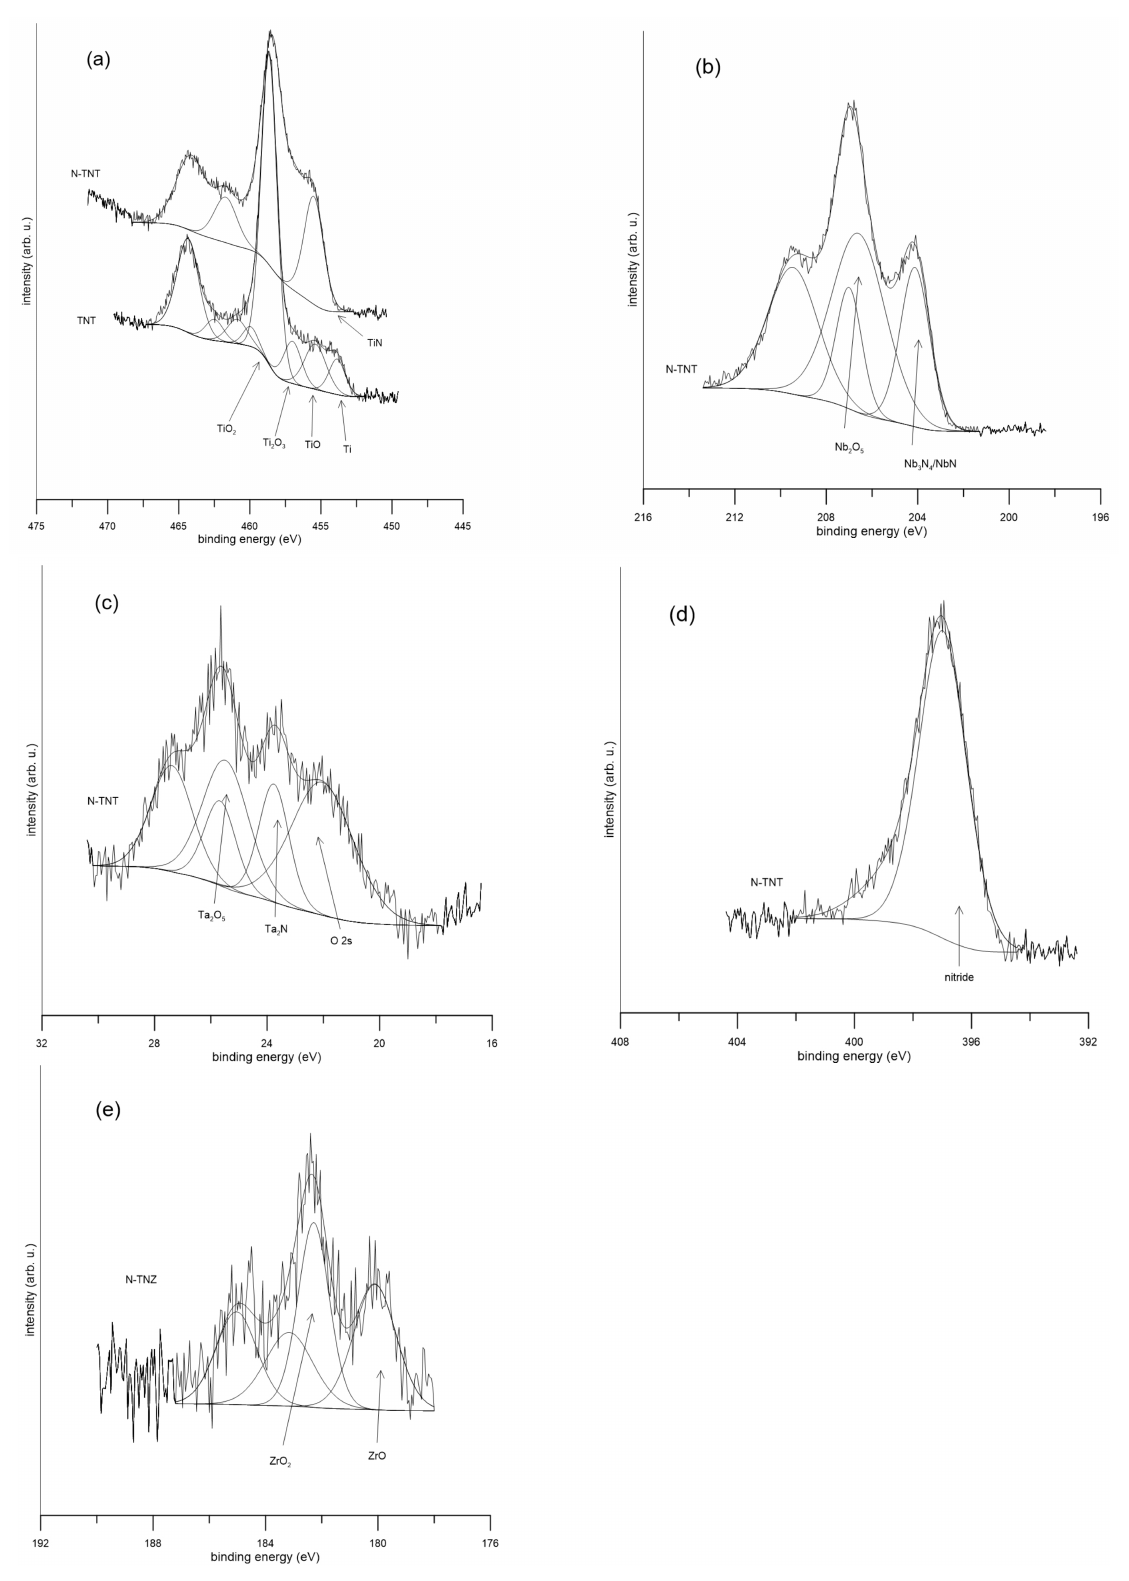
Figure 1. Detailed XPS spectra of selected elements: ( a ) Ti 2p, ( b ) Nb 3d, ( c ) Ta 4f, ( d ) N 1s, ( e ) Zr